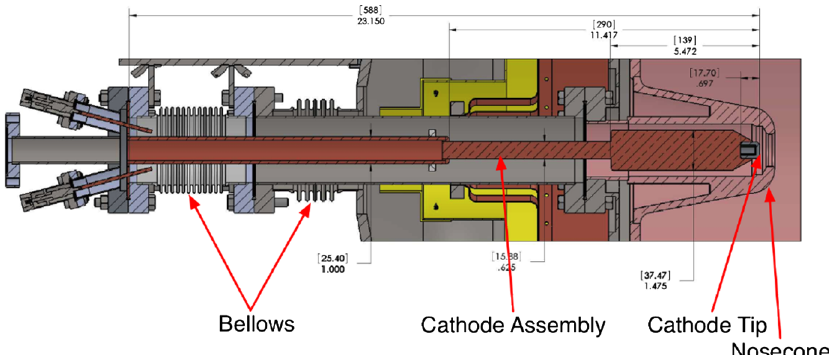
FIG. 5. Detail of cathode stalk from rear shorting plate to cavity.